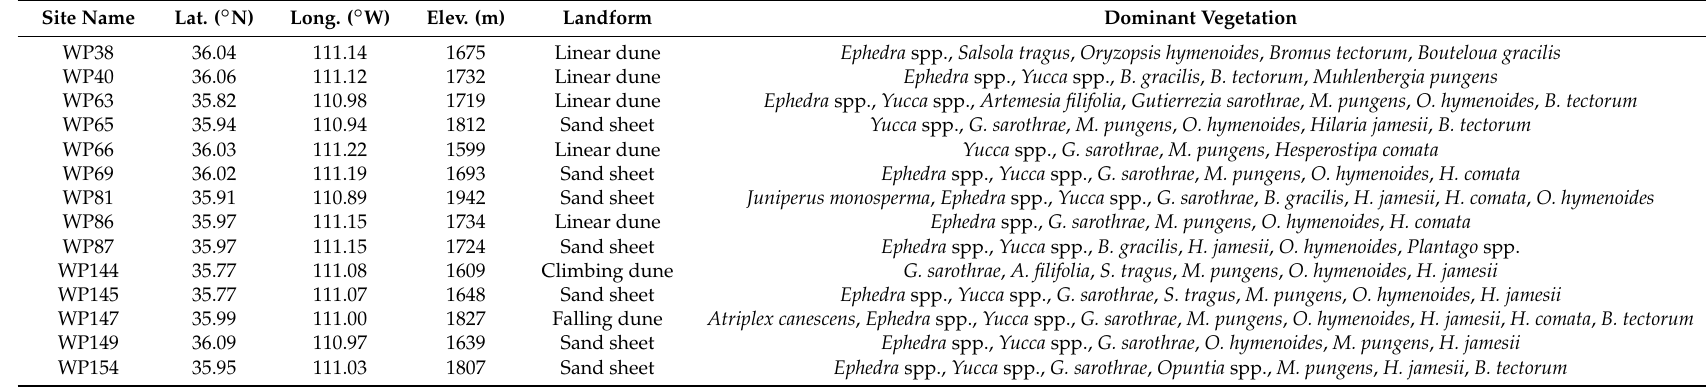
Table 3. Site location, associated landform, and dominant vegetation. Latitude, longitude, and elevation acquired at field sites using a Garmin GPSmap 60 handheld unit. Datum: